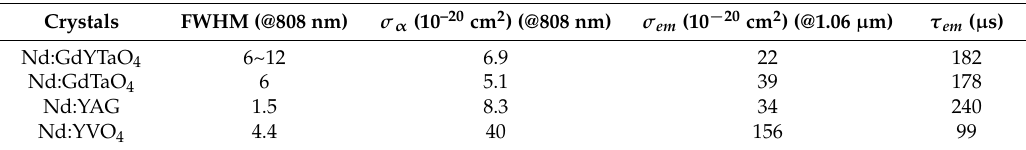
Table 3. Comparison of spectroscopic properties of Nd:GdTaO 4 and Nd:GdYTaO 4 with other Nd-doped laser crystals